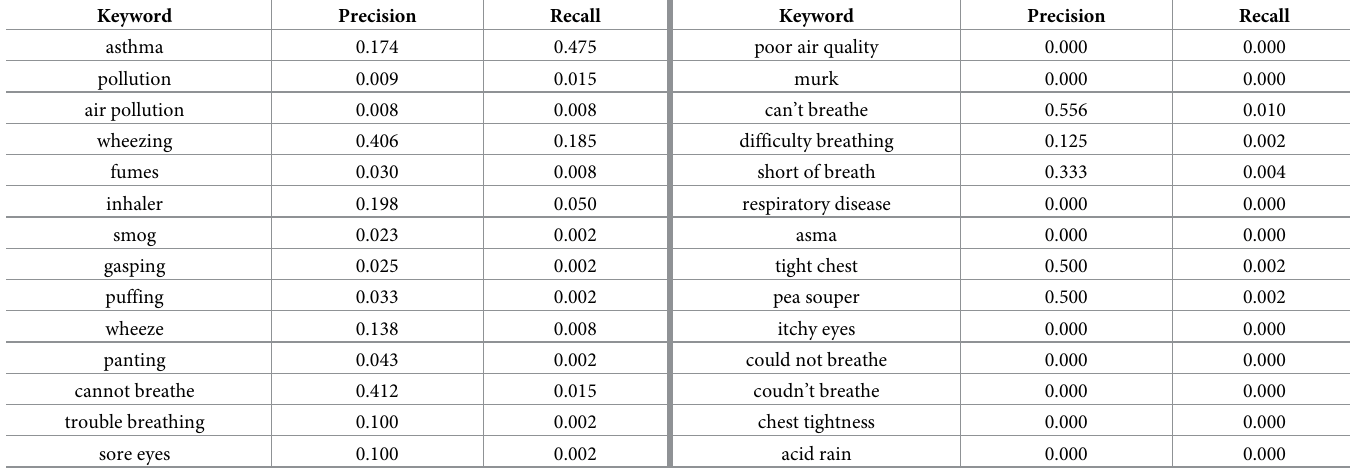
Fig 5. Most frequent emojis in labelled data and their distributions. https://doi.org/10.1371/journal.pone.0210689.g005 Table 13. Assessment of the quality of the search keywords from an information retrieval perspective. Precision is the fraction of retrieved tweets that are relevant to the query. Recall is the fraction of the relevant tweets that are successfully retrieved.